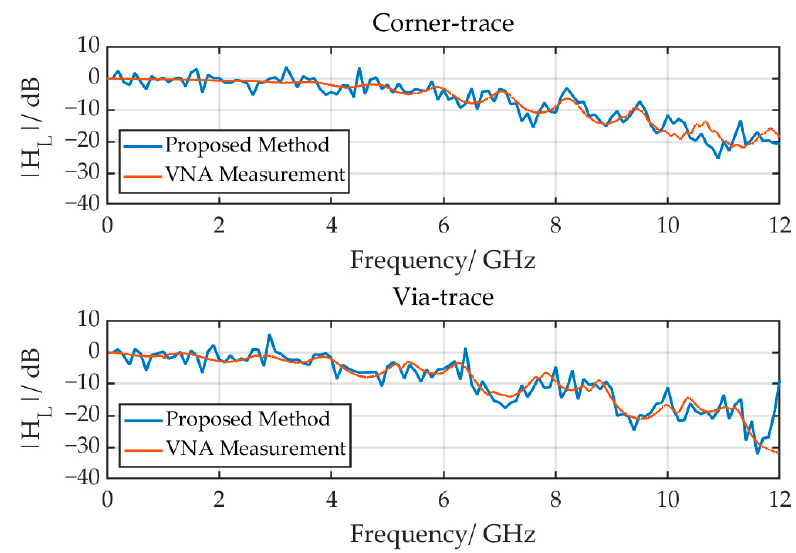
Figure 11. The compared results between the transmission characteristics of a corner trace and a via trace with the proposed method and those obtained using a VNA.